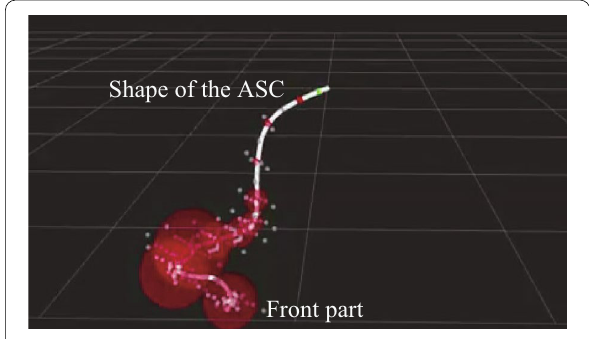
Fig. 10 Pose estimation of ASC in rubble superposed with the voice magnitude (size of circle)